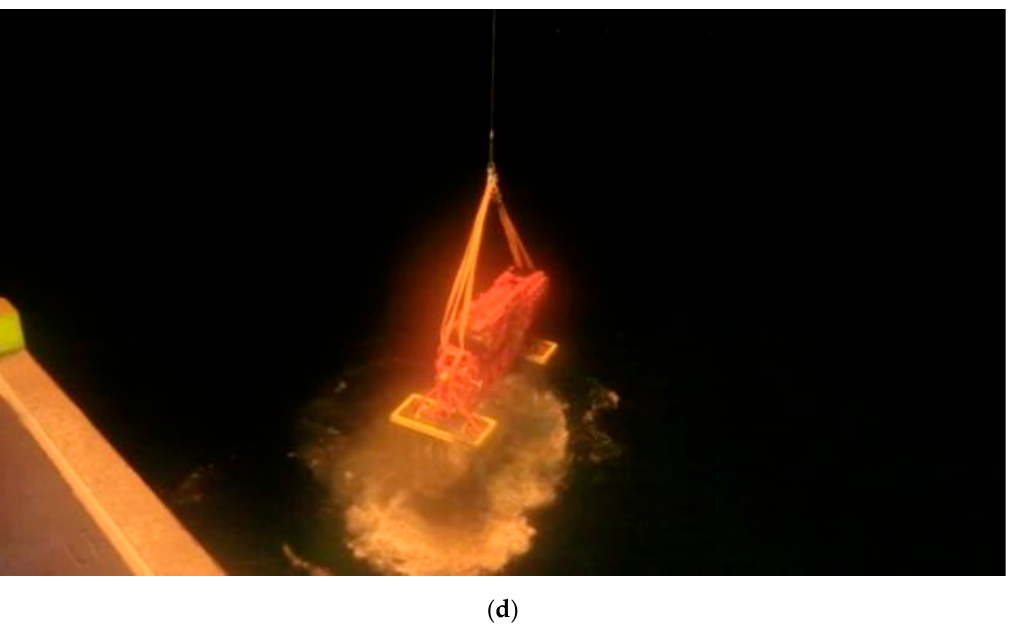
Figure 19. Sea test. ( a ) Put the deep-water bolt flange automatic connection tool into the sea; ( b ) The deep-water bolt flange automatic connection tool in subsea environment; ( c ) ROV operation control panel; ( d ) Take the deep-water bolt flange automatic connection tool back to ship.